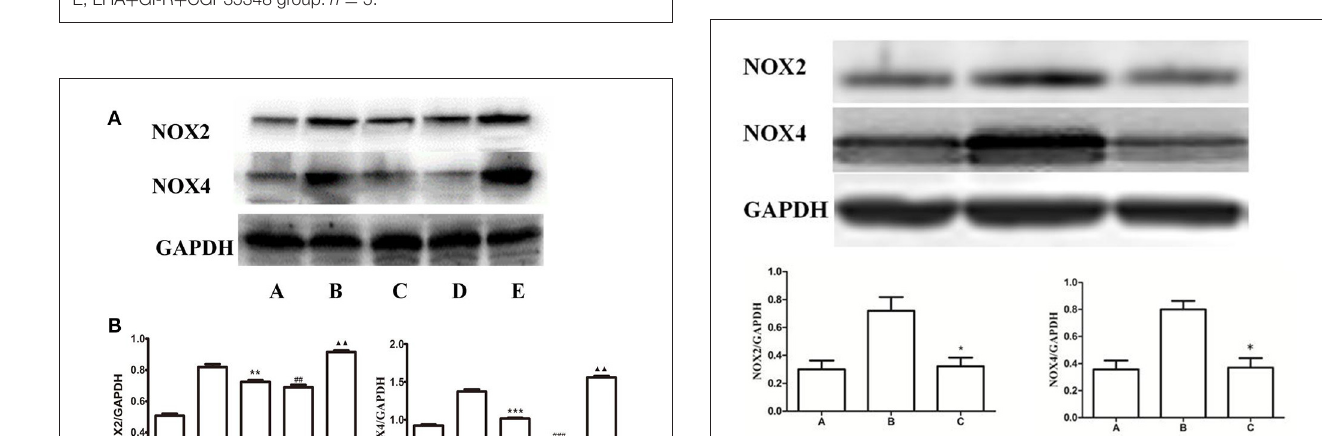
FIGURE 12 | Expression of NOX2 and NOX4 in the gastric mucosa. Western blots of NOX2, NOX4, and GAPDH in gastric mucosa. Quantitative analysis of NOX2 and NOX4 expression in the gastric mucosa. GAPDH was used as a loading control. * P < 0.001, as compared with the GI-R group. A, Normal group; B, GI-R group; C, LHA + GI-R + CGRP group. n =